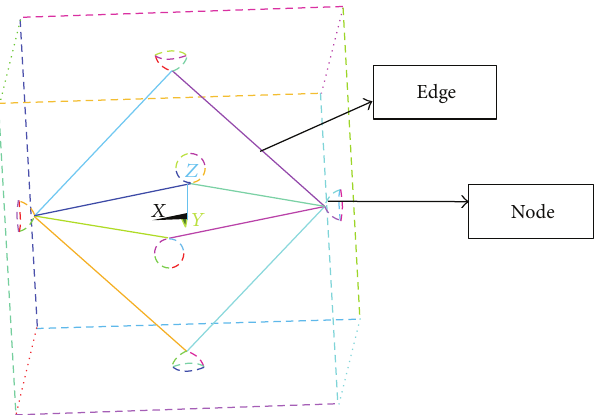
Figure 17: Octahedron model.